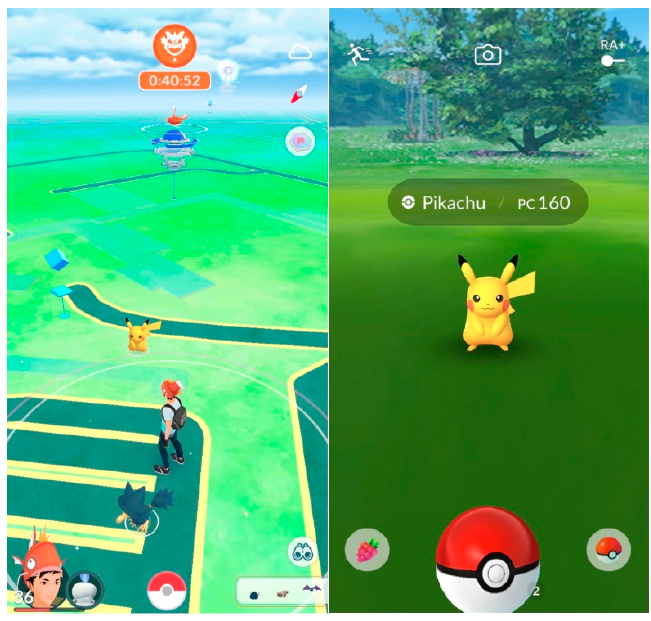
Figure 1. Pokémon Go interfaces. Figure 1. Pok é mon Go